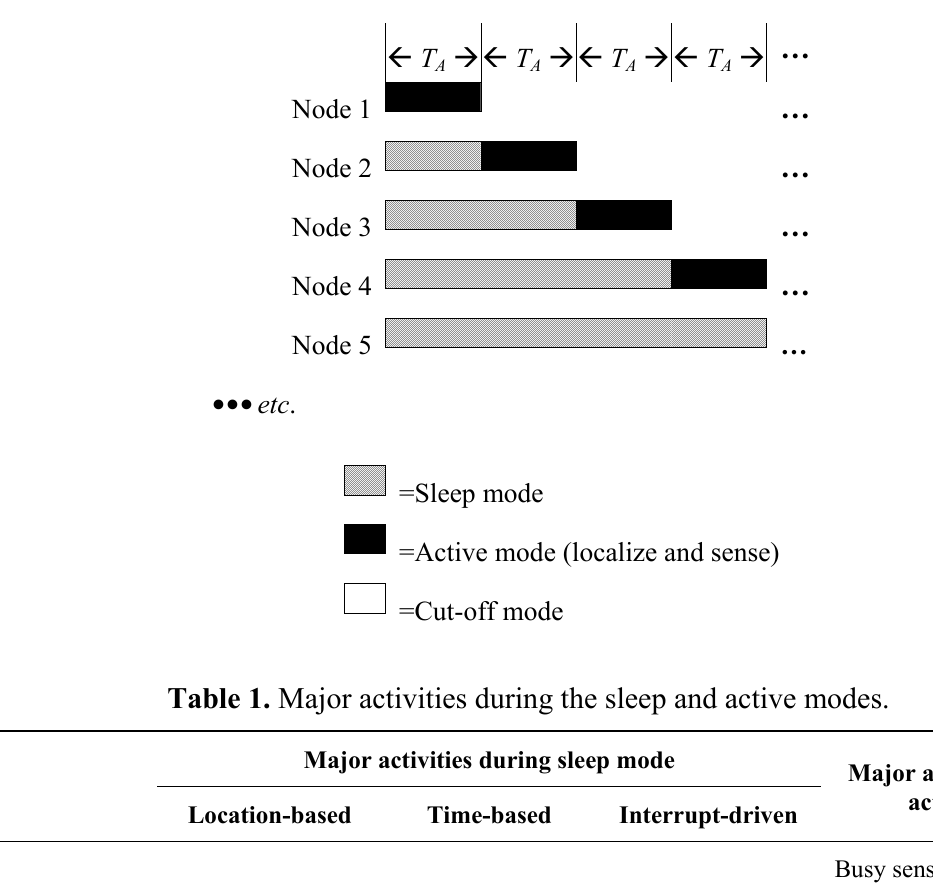
Figure 2. Sleep-active modes of the proposed design.